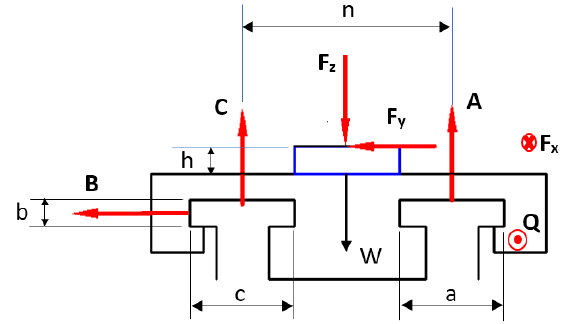
Figure 8. A schematic diagram of the slider and guideways design.